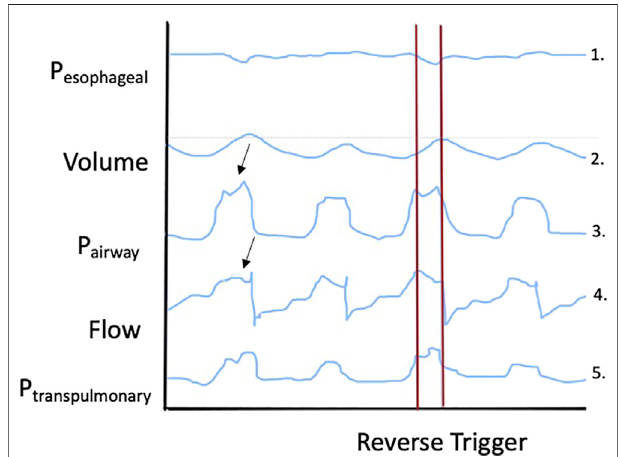
FIGURE 3 | Theoretical depiction of a waveform tracing for a reverse triggering event. Key elements of this waveform tracing to note include: 1) a maximal patient effort occurring during lung in fl ation, 2) a larger tidal volume during the reverse trigger event, 3) inspiratory effort resulting in a slight negative dip in airway pressure, 4) sharply increased fl ow during the reverse trigger event, and increased transpulmonary pressures (both mean and end- inspiratory) during the reverse triggering